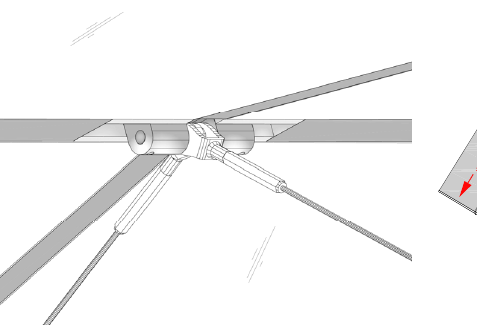
Figure 6: Steel element, connecting four glass elements